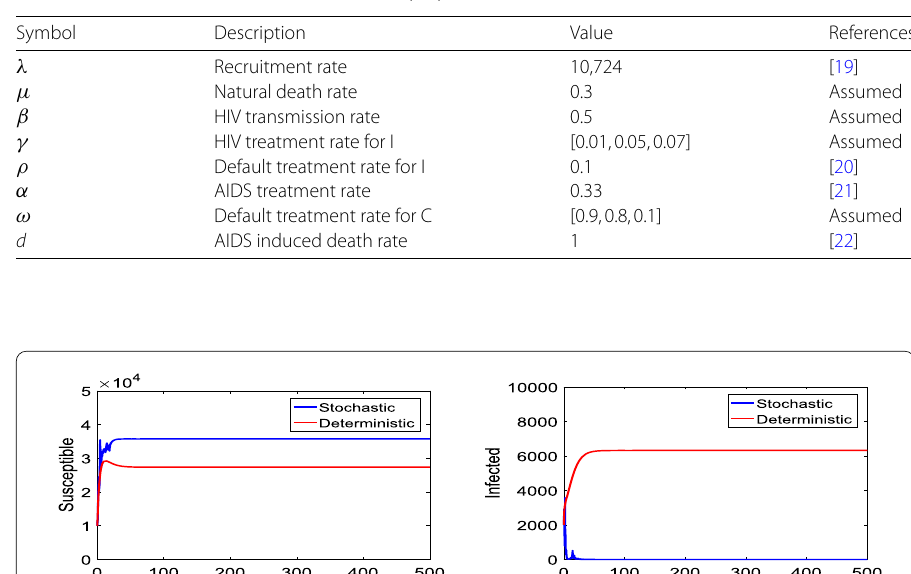
Table 1 Parameters of the HIV/AIDS model